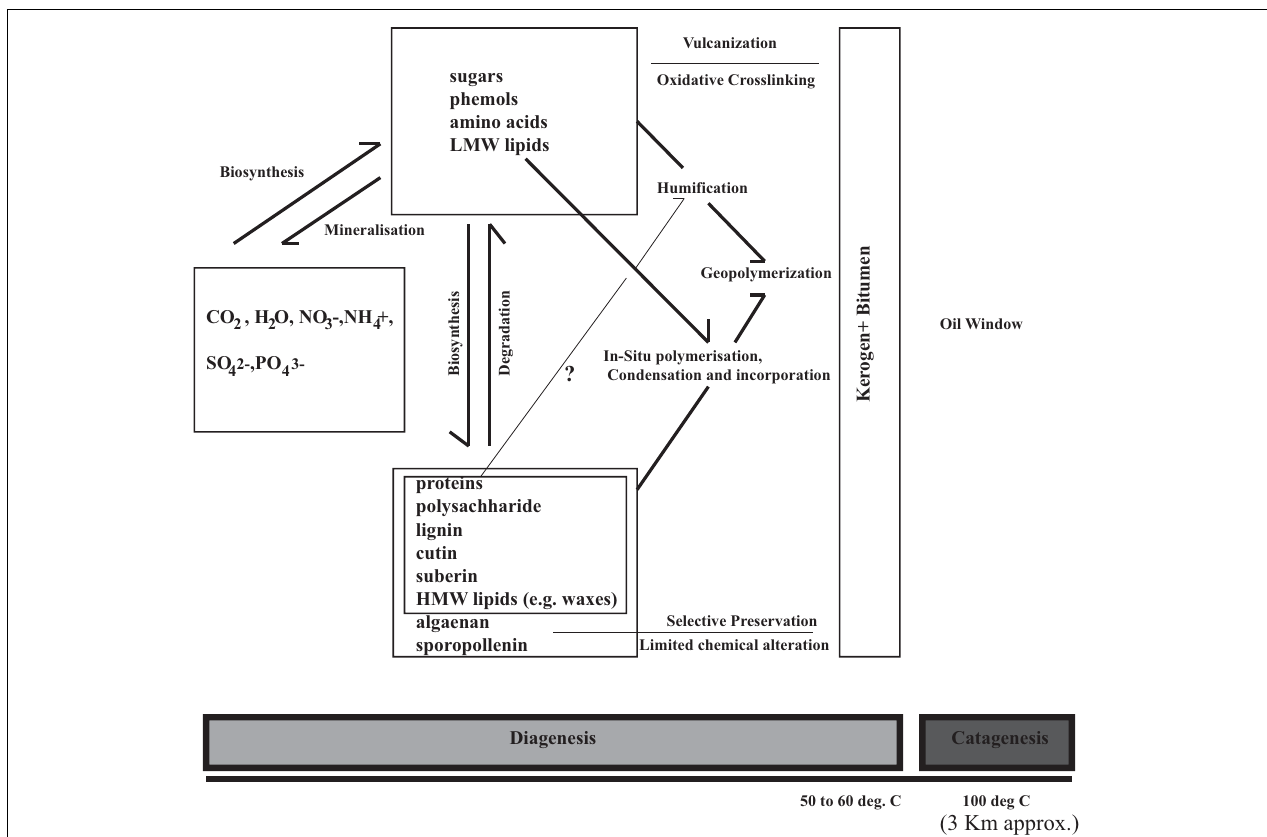
FIGURE 1 | A concept diagram proposing and integrating the pathways of organic matter preservation in tandem with selective preservation (that requires presence and limited change of precursor recalcitrant biopolymer) .